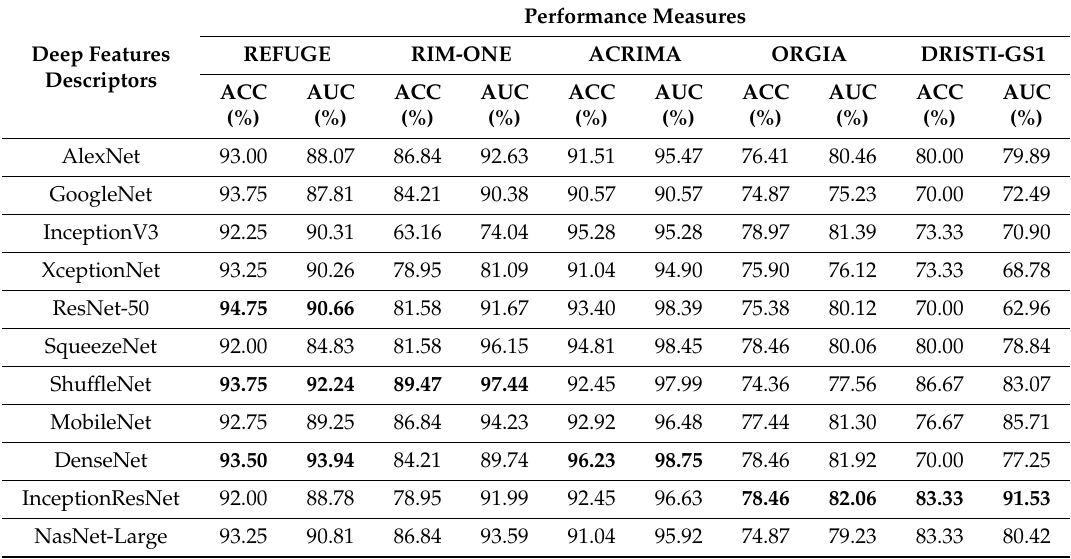
Table 6. P2: Deep activated features from eleven pretrained networks and SVM for glaucoma classification.